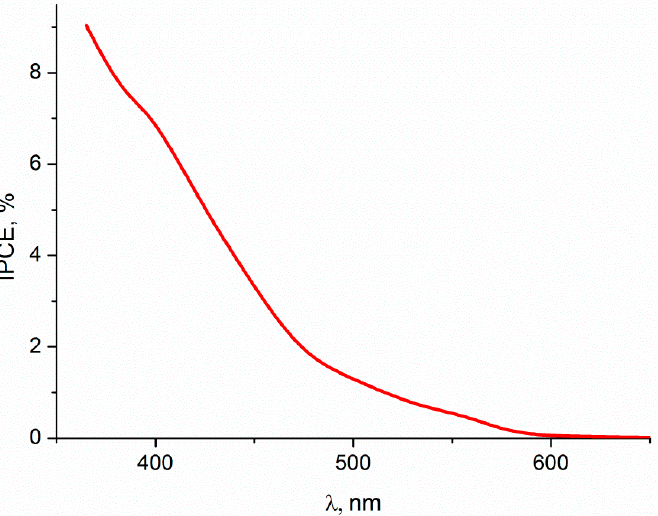
Figure 8. IPCE% spectrum for a Ti 4+ /Fe 2 O 3 /FTO photoanode in an aqueous solution of 0.1 M KOH + 20% C 3 H 5 (OH) 3 .